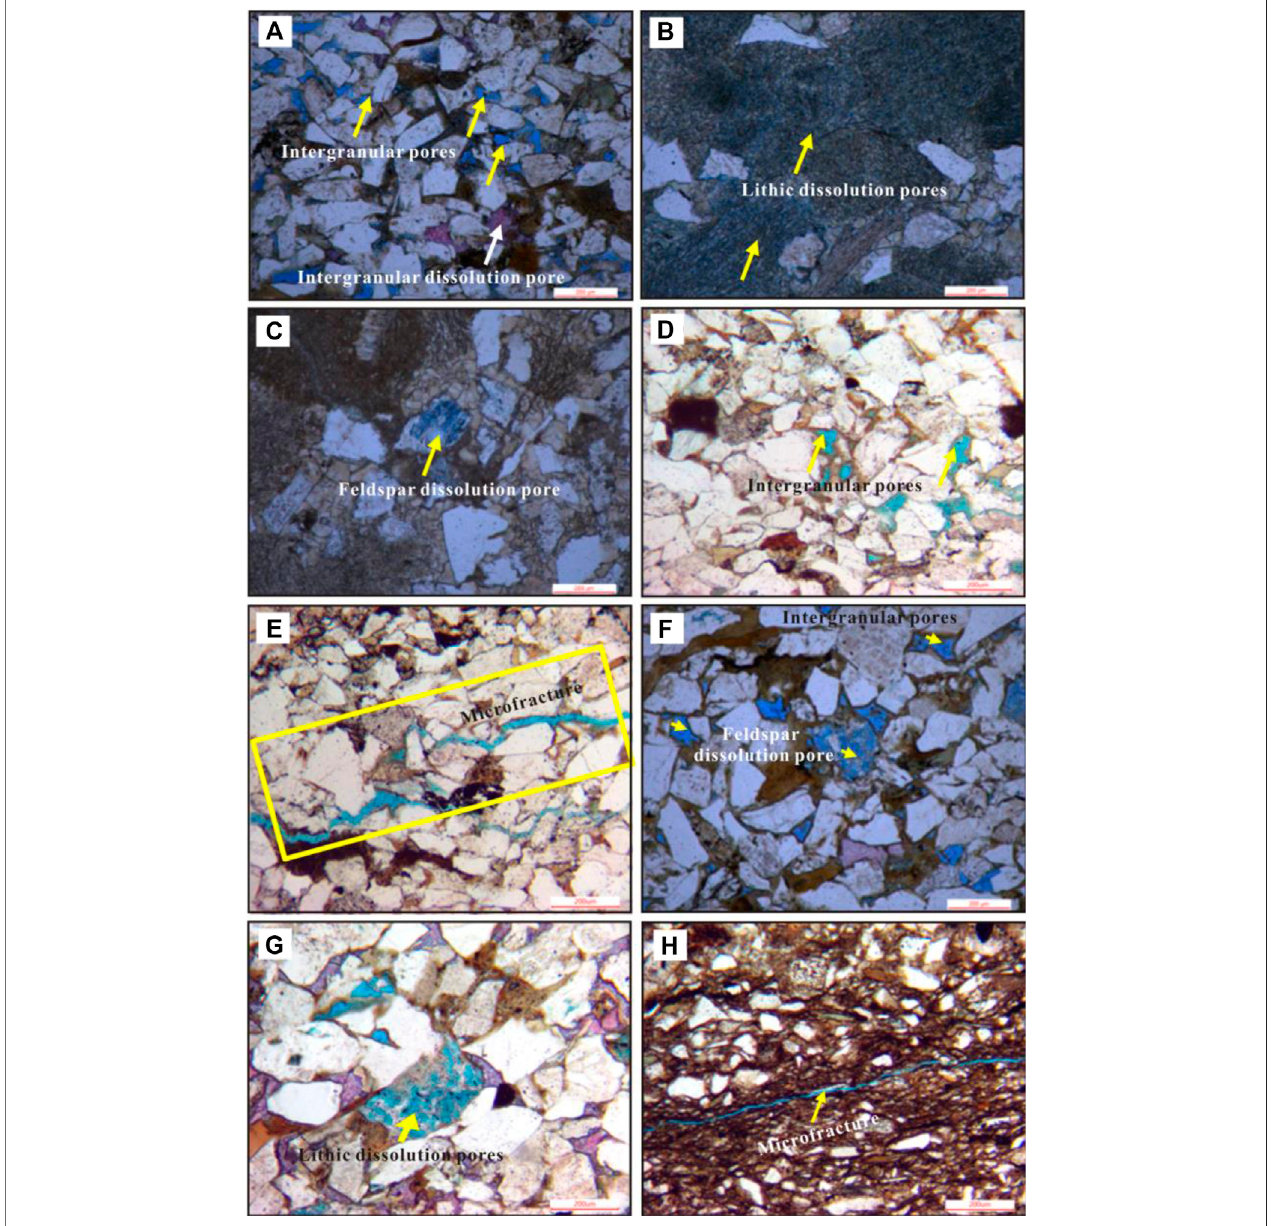
FIGURE1| Microscopicimagesoftightsandstonesamplescollectedfromthetargetlayer.Notes: (A) WellY4,1731.46 m,intergranularpores,Chang6Member; (B) Well Y6, 1 839.71 m, lithic dissolution pores, Chang 6 Member; (C) Well Y6, 1 839.71 m, feldspar dissolution pores, Chang 6 Member; (D) Well F6, 1 857.87 m, intergranular pores, Chang 7 Member; (E) Well F6, 1 857.87 m, microfractures, Chang 7 Member; (F) Well DT4, 2 212.99 m, intergranular pores and feldspar dissolution pores, Chang 8 Member; (G) Well DT4, 2 213.00 m, lithic dissolution pores, Chang 8 Member; (H) Well DT4, 2 244.80 m, microfractures, Chang 8